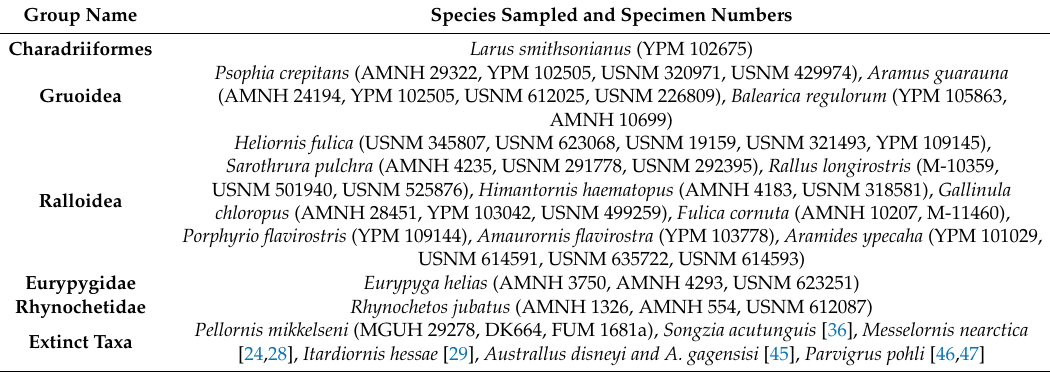
Table 3. Specimen numbers of newly added taxa and skeletal specimens used for comparison during fossil description. The institutional abbreviation key is provided in Materials and